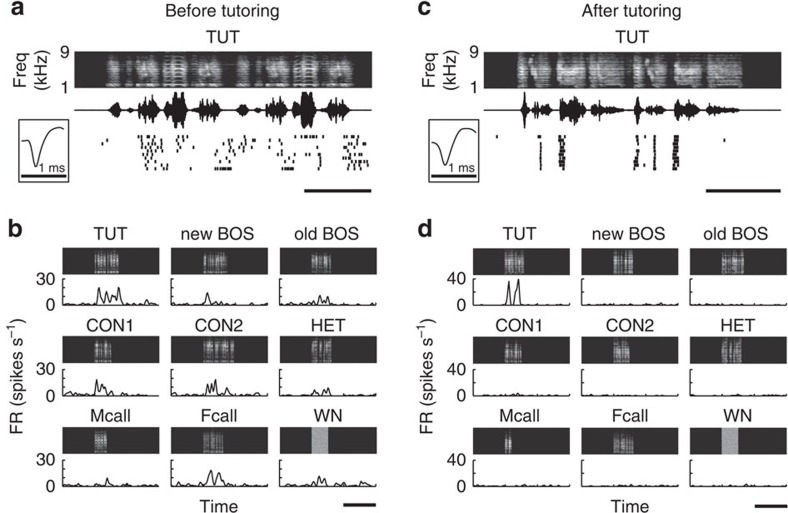
Emergence of tutor song-selective BS neurons after tutoring.A representative non-selective BS neuron recorded before tutoring (59 days of
age) (a,b) and a tutor song (TUT)-selective BS neuron recorded
9 days after tutoring (64 days of age) (c,d). Neural responses
to playback of the tutor song (TUT) are shown as a raster plot (bottom)
time-aligned with the TUT spectrogram (top) and oscillogram (middle)
(a,c). Scale bars, 400 ms. Inset: mean spike
waveform. Mean firing rate (FR) curves (10 ms, smoothed with a
Gaussian kernel) for each auditory stimulus (b,d). Note that
highly reliable and precisely time-locked selective spiking responses to
playback of the TUT occur after tutoring. BOS, the bird's own song;
CON, conspecific song; Fcall, female call; HET, heterospecific song; Mcall,
male call; TUT, tutor song; WN, white noise. Scale bars, 2 s